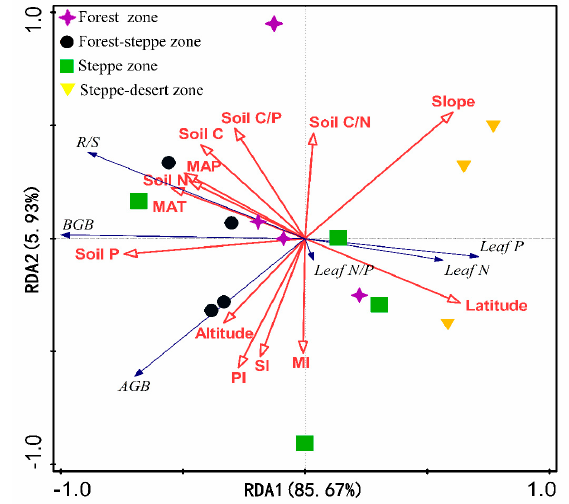
— — — — — — AGB, above-ground biomass; BGB, below-ground biomass; R/S, root-to-shoot ratio; SLO, slope; SOP, Soil P content; LAT, latitude; ALT, altitude; MAT, mean annual temperature; MAP, mean annual precipitation (** p < 0.01;). All climate data (MAT and MAP) was obtained from China Me- teorological Data Sharing Service System (http://data.cma.cn/, Accessed on 10 May 2021).